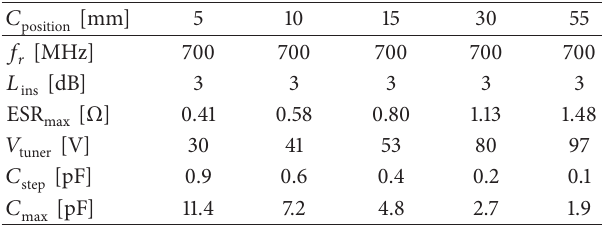
Figure 2: Antenna tuning, with tuner placed in 𝐶